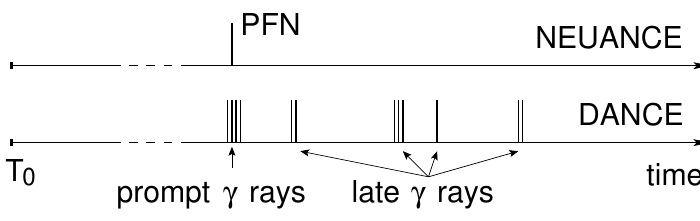
Figure 2. A schematic train of events in DANCE and NEUANCE with time starting from the beginning of the neutron spill T 0